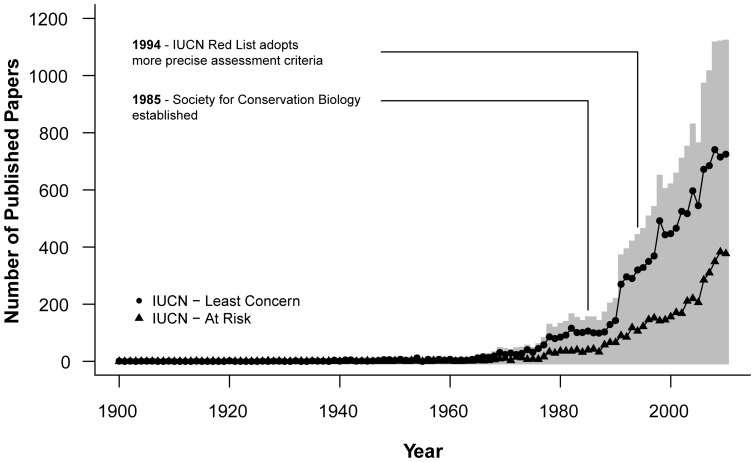
The number of Carnivore papers published per year from 1900–2010 for species of Least Concern and at-risk species (IUCN Near Threatened, Vulnerable, Endangered and Critically Endangered).The barplot shows the total number of papers per year.